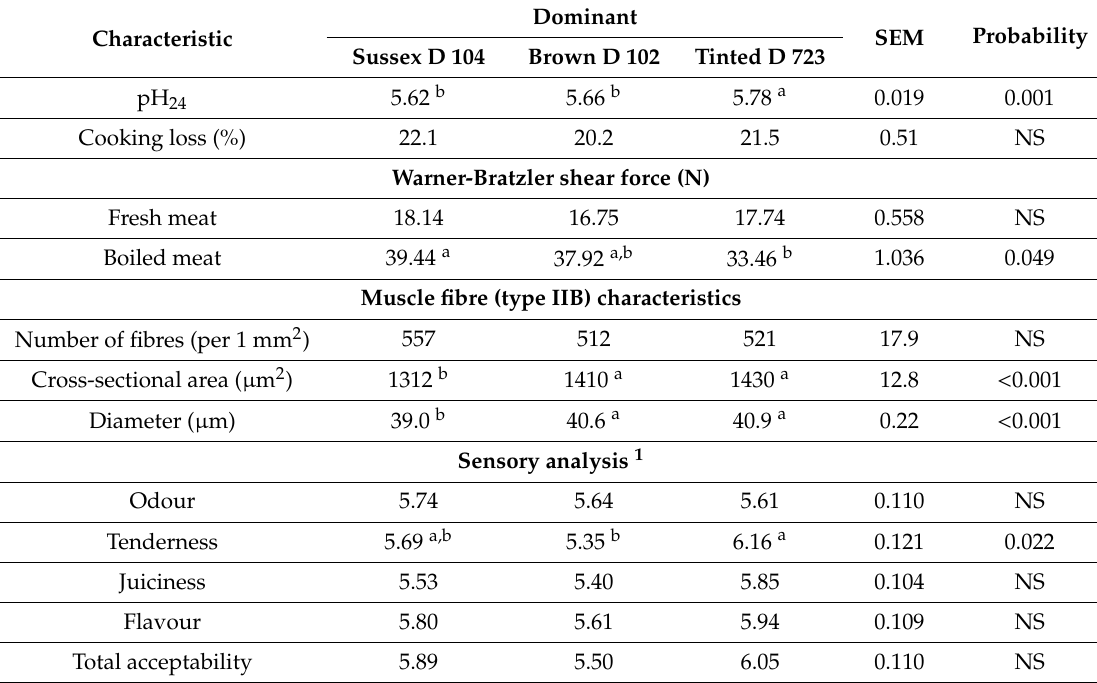
Table 4. Physical characteristics, muscle fibre characteristics and sensory analysis of breast